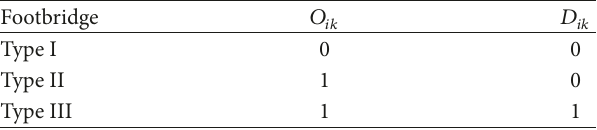
Table 3: 𝑂 𝑖𝑘 and 𝐷 𝑖𝑘 associated with type of footbridge.